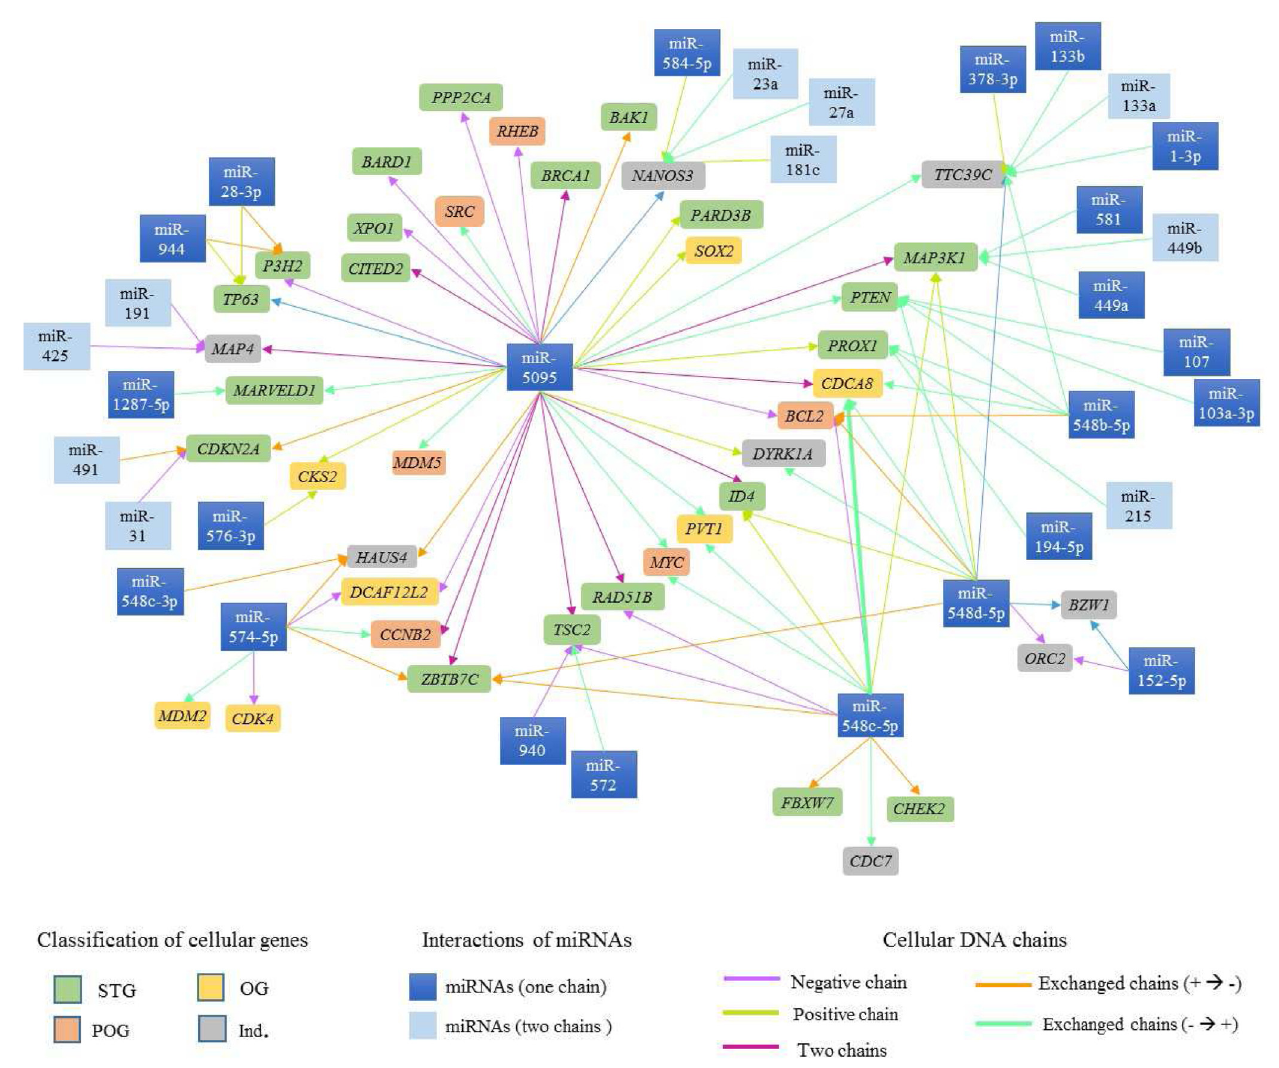
Figure 6. Possible network of interactions between miRNAs associated with development of CC and cell cycle regulatory genes present at HPV integration sites. The cell cycle regulatory genes in rectangles of various colors are presented, depends on their classification (ST - , OG - , POG - e IND - ). The arrows represent the interactions between miRNAs and genes involved in cell cycle regulation, dates color depends on the DNA chain where miRNAs and cell cycle regulatory genes are located.